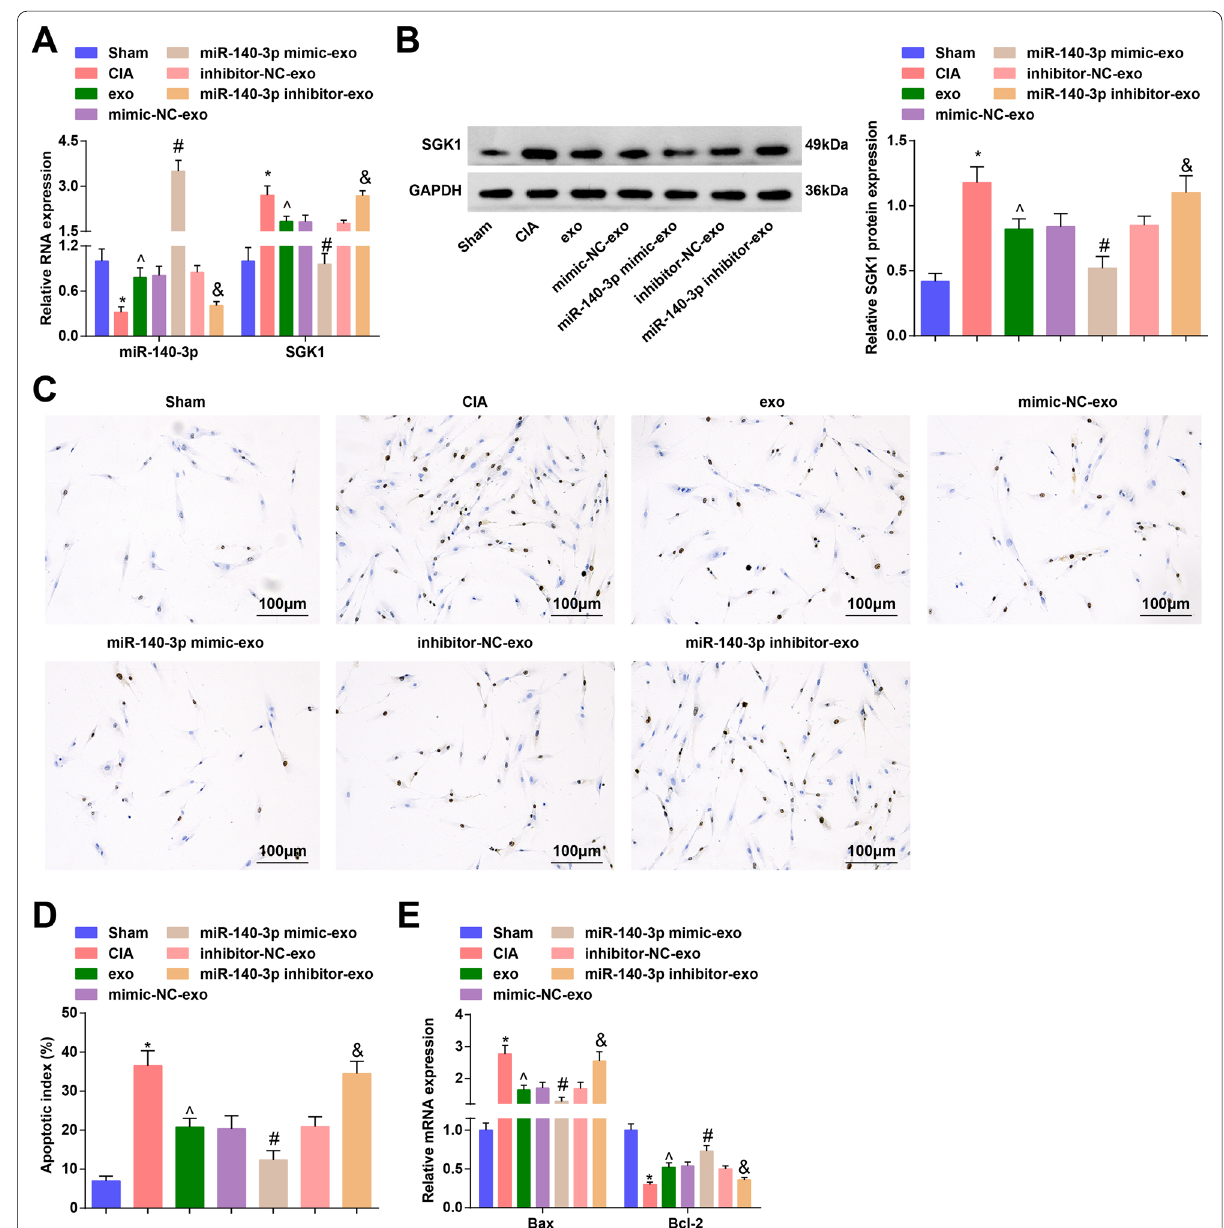
Fig. 3 HUCMSCs-exo or exosomal miR-140-3p alleviates chondrocyte apoptosis in RA rats and decreased miR-140-3p reverses impact of HUCMSCs-exo on chondrocyte apoptosis in RA rats. A Expression of miR-140-3p and SGK1 in cartilage tissues was determined by RT-qPCR; B Protein expression of SGK1 in cartilage tissues was determined by Western blot analysis; C Apoptosis of chondrocytes was observed through TUNEL staining; D AI of chondrocytes in each group; E mRNA expression of Bax and Bcl-2 in cartilage tissues was determined using RT-qPCR; n * P < 0.05 vs the sham group, ^ P < 0.05 vs the CIA group, # P < 0.05 vs the mimic-NC-exo group, & P < 0.05 vs the inhibitor-NC-exo group; the data were expressed as mean standard deviation, ANOVA was used for comparisons among multiple groups and Tukey’s post hoc test was used for pairwise ± comparisons after